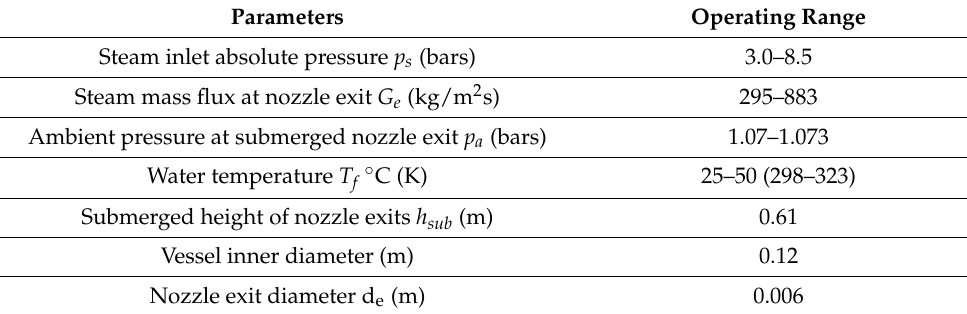
Figure 1. ( a ) Schematic of an experimental setup and ( b – d ) the geometrical arrangements of the sensors used; ( e ) the schematic flow diagram. Table 2. Experimental operating